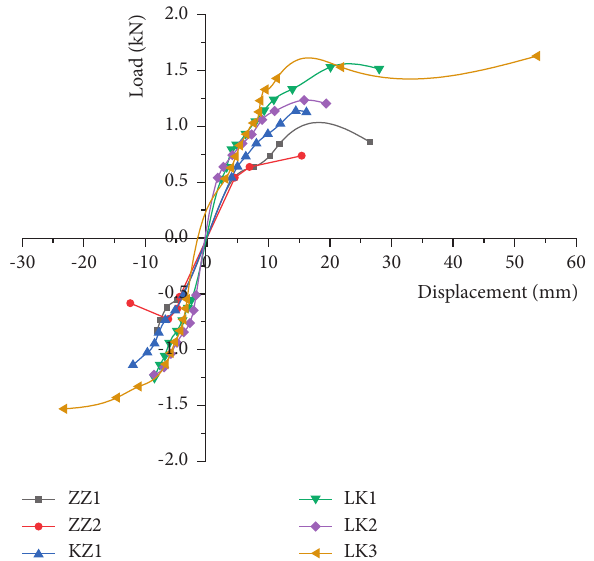
Figure 12: Skeleton curves of three kinds of test